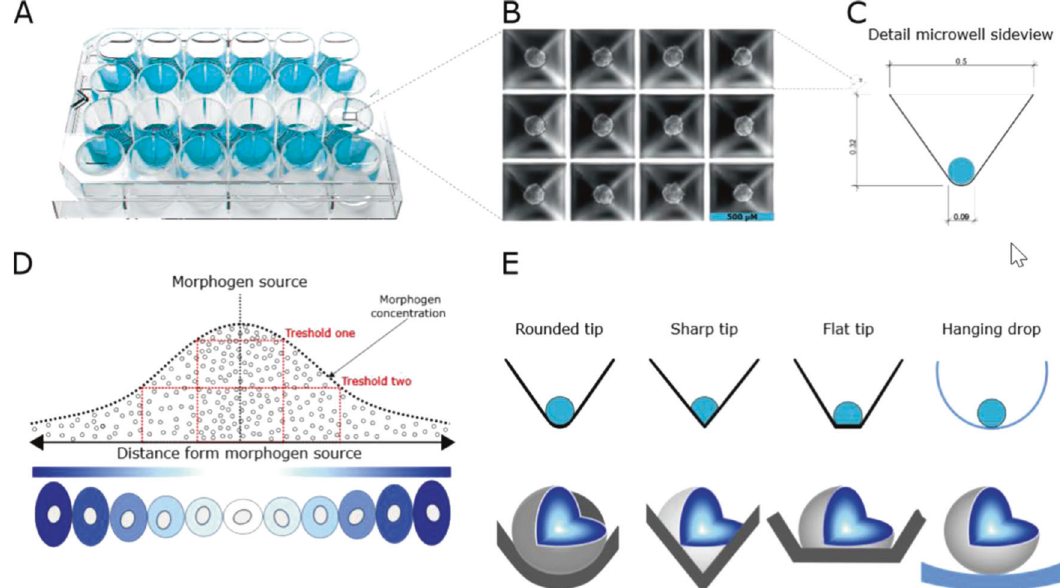
Fig. 1 Plate design, geometry and resulting scienti fi c advantages. Layout of the Sphericalplate 5D highlighting the 12 working wells A . Image of spheroids formed in the microwells within one of the wells of the plate B . Shape and measurements of the microwell C . Schematic illustration of a concentration gradient of morphogen D [modi fi ed from 23]). Advantage of rounded-tip design of microwell on spheroid formation E